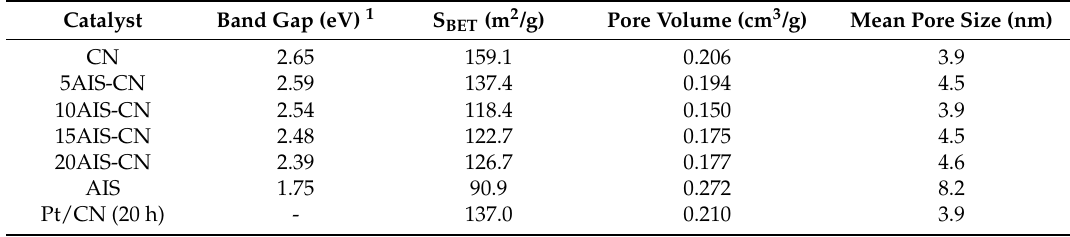
Table 2. Structural properties of as-prepared (without deposited Pt) and used photocatalysts. Catalyst Band Gap (eV) 1 S BET (m 2 /g) Pore Volume (cm 3 /g) Mean Pore Size